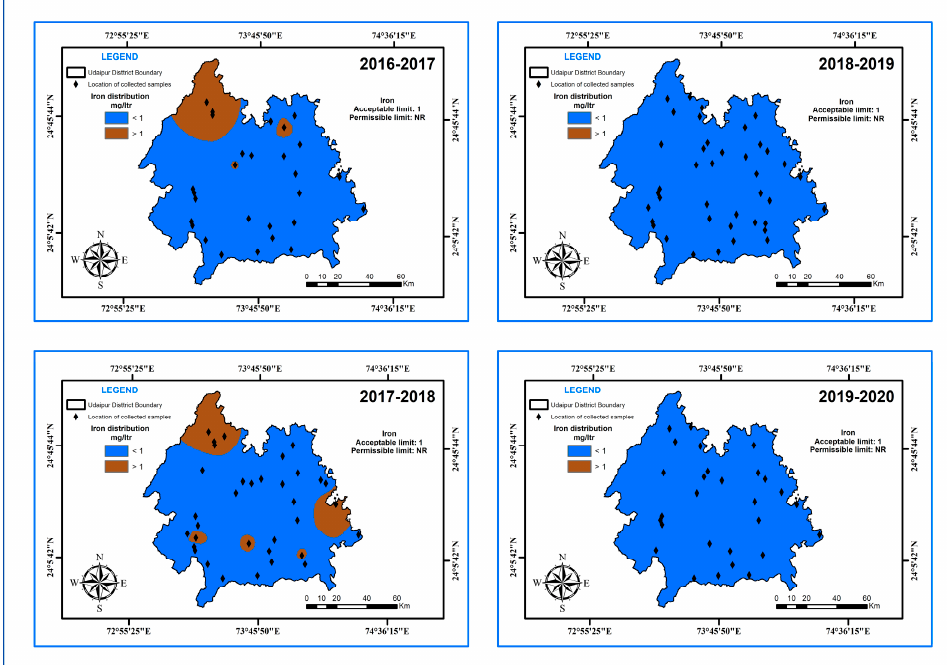
Figure 22. The changing distribution of iron from 2016–2018 in the study area.